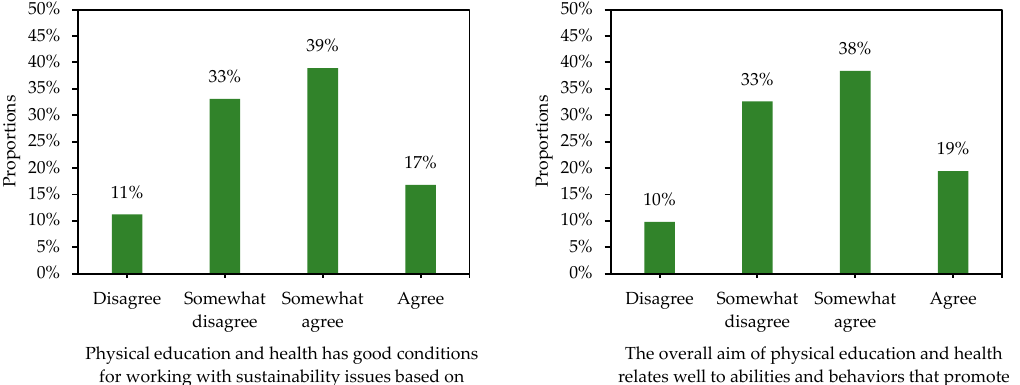
Figure 4. Distribution of proportions for the two statements about SD in relation to the PEH syllabus for those participants who reported teaching PEH when completing the questionnaire (total sample: both n = 553).